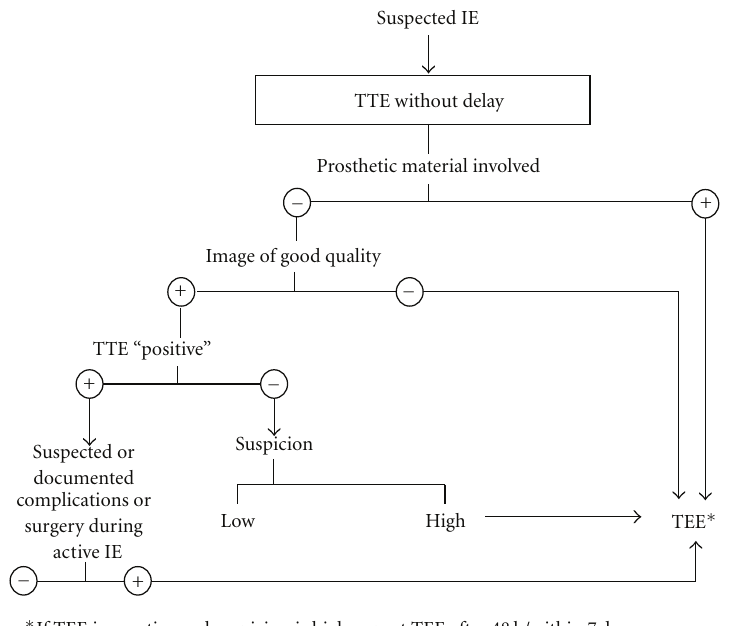
Figure 3: Algorithm for the use of transthoracic (TTE) and transesophageal echocardiography (TEE) in suspected IE. Note: TTE “positive” indicates finding typical of IE (e.g., fresh vegetation or abscess